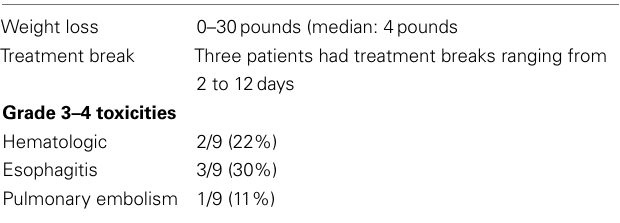
Table 2 |Treatment toxicity